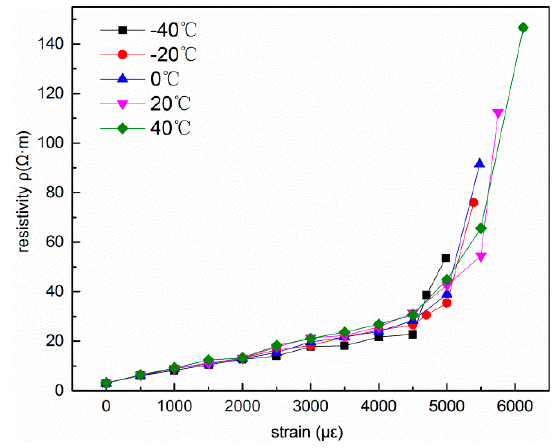
Figure 7. ρ - ε curve. Figure 7. ρ - ε